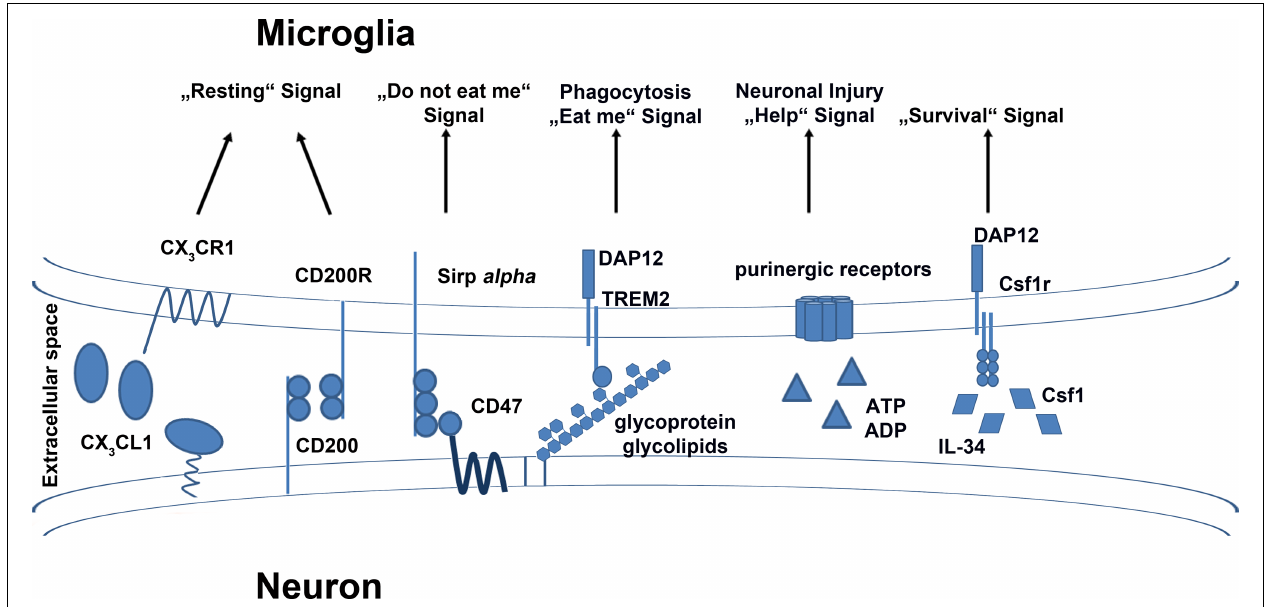
Receptors such asTREM2 and purinergic receptors are essential to mimic neuronal injury and induce phagocytotic and anti-inflammatory functions in microglia.The crosstalk between microglia and neurons is also important for the survival of microglia. Neurons release factors like IL-34 and Csf1 which bind to Csf1r on the surface of microglia and induce cell survival or